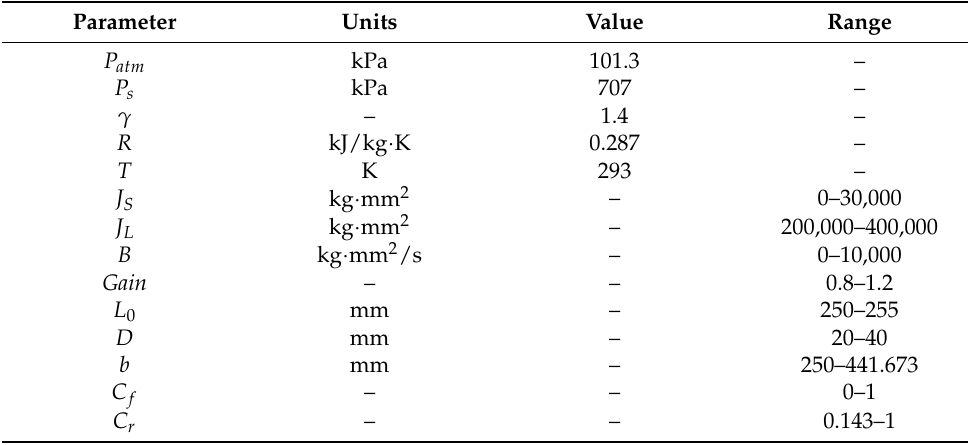
Table 3. Parameter table of the model of the proportional flow control servo